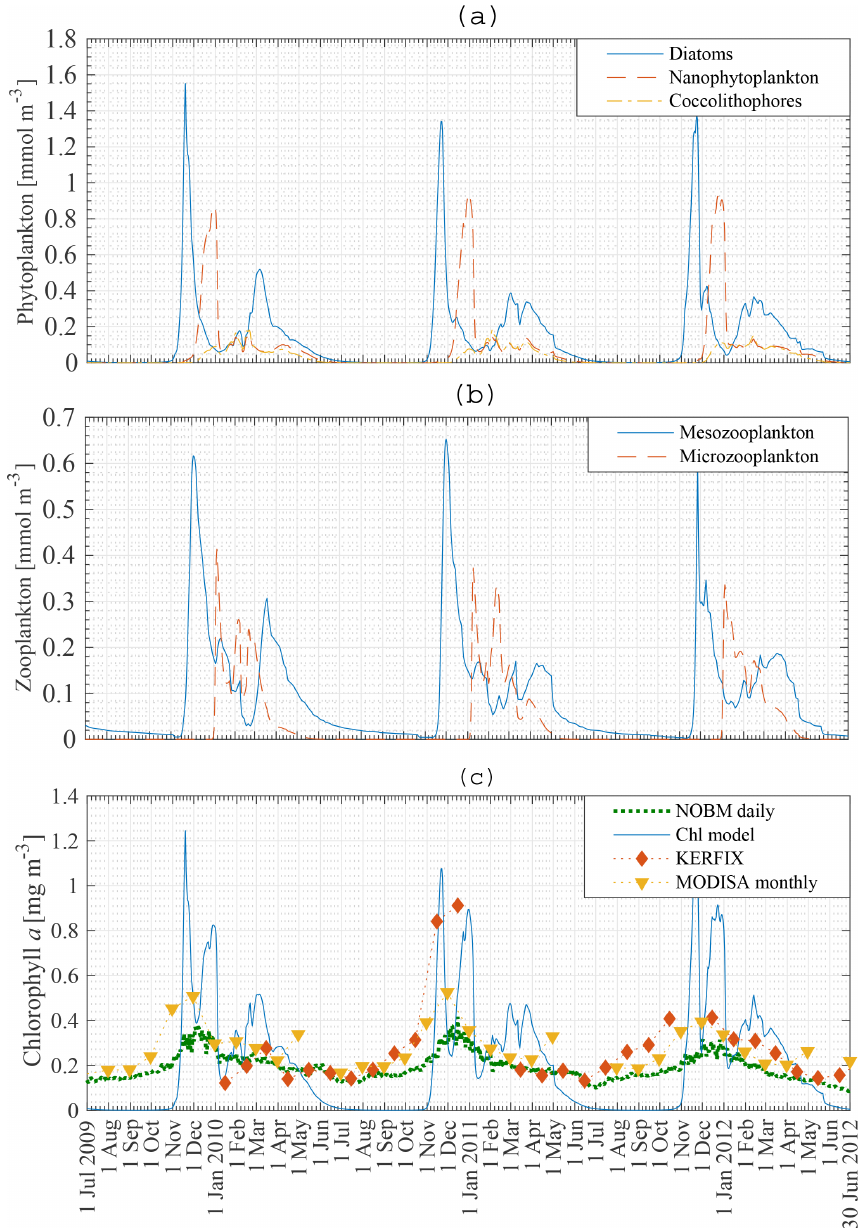
Figure 7. Model result: diatom, nanophytoplankton and coccolithophore concentration (a) , mesozooplankton and microzooplankton concen- tration (b) , and chlorophyll a concentration compared to KERFIX in situ data ( (cid:7) ), to MODISA satellite data ( (cid:72) ) and to NOBM results ( ... ) (c) in the mixed layer at station 18 from 1 July 2009 to 30 June 2012. KERFIX in situ data from January 1992 to June 1994.